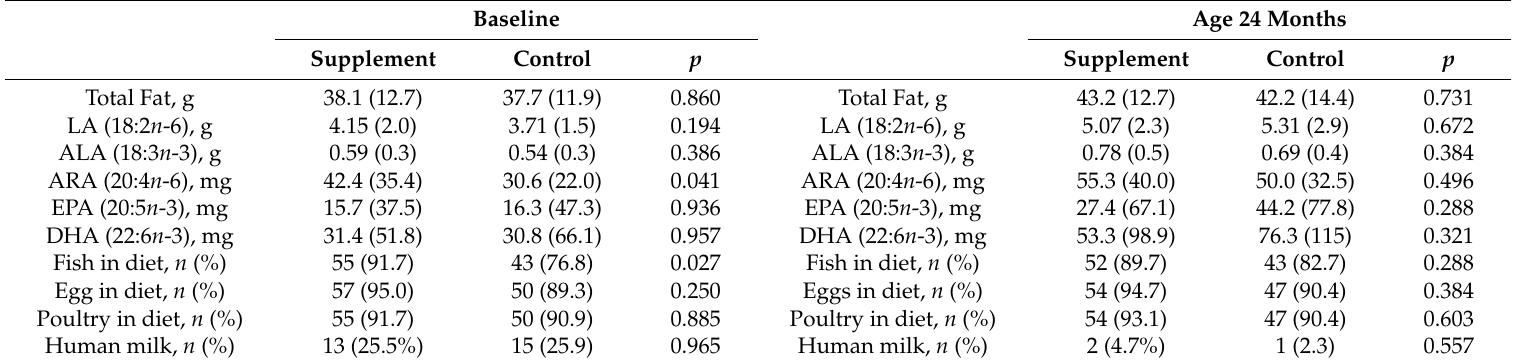
Table 3. Daily dietary intakes of children at baseline and age 24